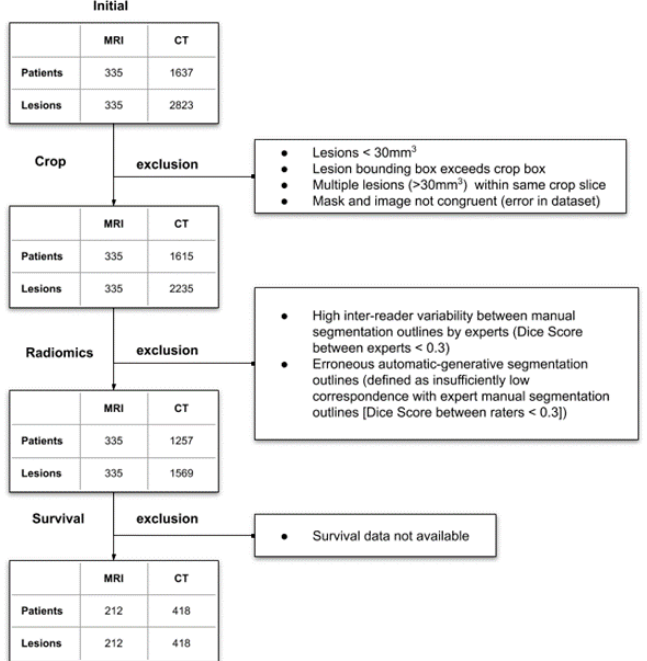
Figure 1. Flow chart showing patient and lesion details as well as exclusion criteria for each step of the post-processing pipeline. NN—Neural Network. A more detailed visualization of the data pro- cessing pipeline can be found in Appendix A Figure